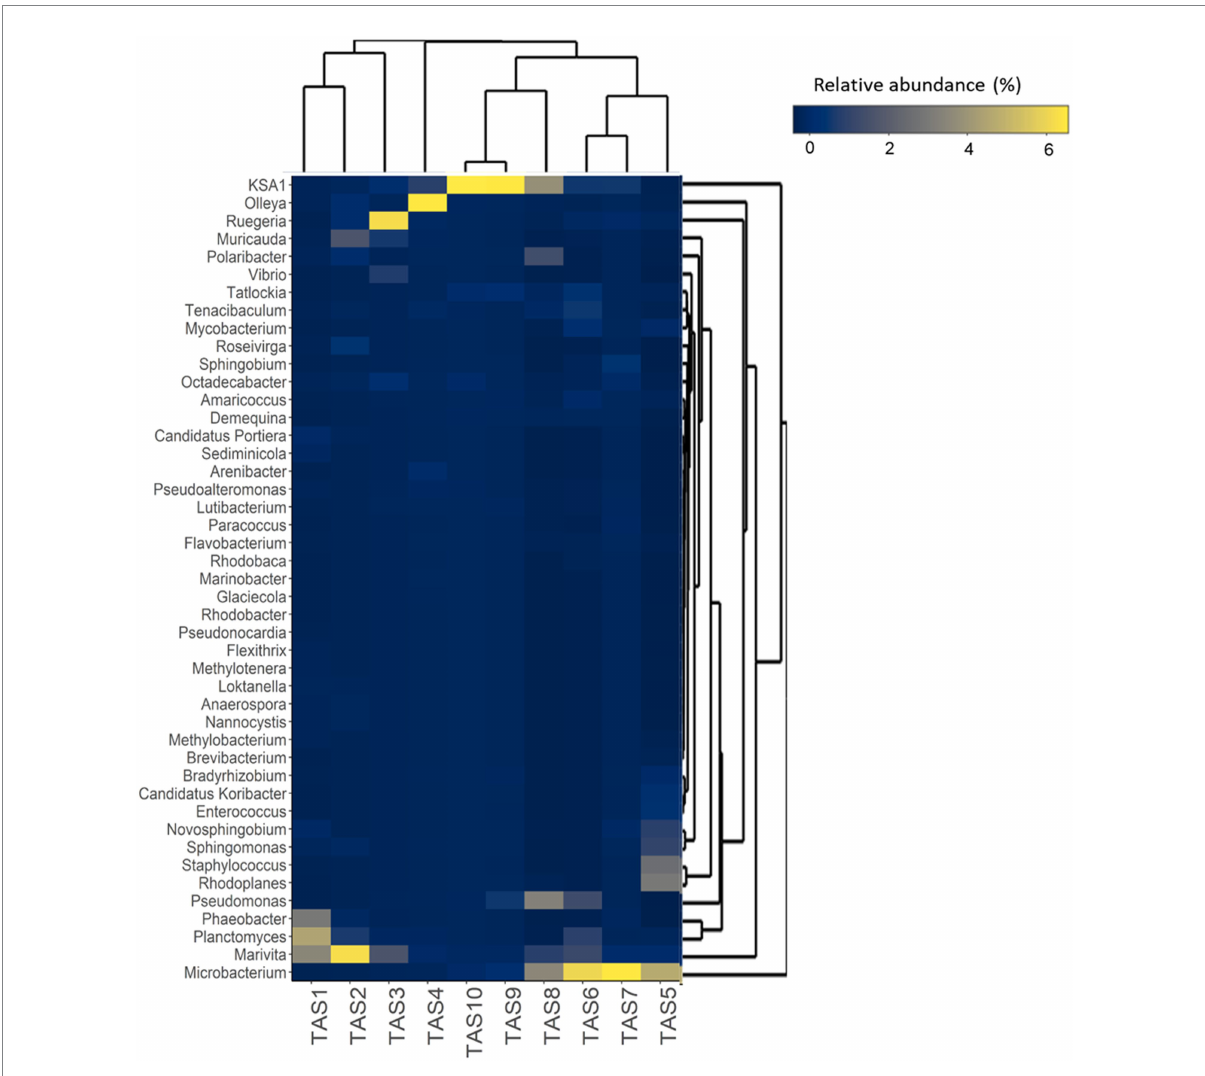
FIGURE 4 Temporal dynamics in bacterioplankton community composition of rearing water at the genus level. The hierarchically clustered heatmap shows the relative abundance of dominant (top 45) bacterioplankton genera in the rearing water during various culture stages. The color intensity in each cell represents the relative abundance of bacterial genera (listed to the left of the figure) at various shrimp culture stages (indicated at the bottom of the figure), according to the color scale at the right. The culture stages (TAS1 to TAS10) represented here denote shrimp Litopenaeus vannamei growth days 6, 20, 34, 48, 69, 83, 104, 118, 132, and 146,